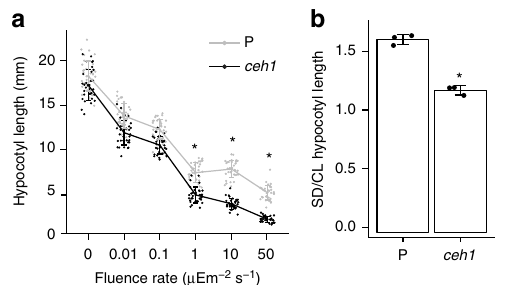
Fig. 3 Photosensory hypersensitivity of ceh1 . a Seeds of P and ceh1 were germinated and grown under continuous red light of various fl uence rate (0, 0.01, 0.1, 1, 10, and 50 μ Em − 2 s − 1 ) for 7 days before hypocotyl length measurements. Dark grown ( fl uence rate 0) seedlings were used as control. b P and ceh1 seeds germinated and grown under short-day (SD; 8 h light/16 h dark) or continuous white light (CL) for 7 days were subsequently subjected to hypocotyl length measurements. Data in ( a ) and ( b ) are mean ± SD, each with three biological replicates and 45 seedlings per replicate. Asterisks denote signi fi cant differences as determined by a two-tailed Student ’ s t tests with a signi fi cance of P < 0.05 of ceh1 / PIF5-OX , a phenotype consistent with their differential growth phenotypes, namely larger ceh1 / PIF5-OX seedlings (Fig. 4b, e and Supplementary Fig. 2c).